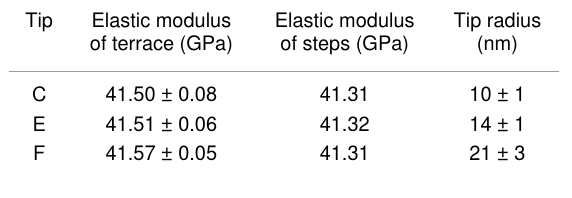
Table 1: The elastic modulus measured from FMM measurements of graphite surfaces and uncovered atomic steps from three different tips. Tip Elastic modulus Elastic modulus of terrace (GPa) of steps (GPa)